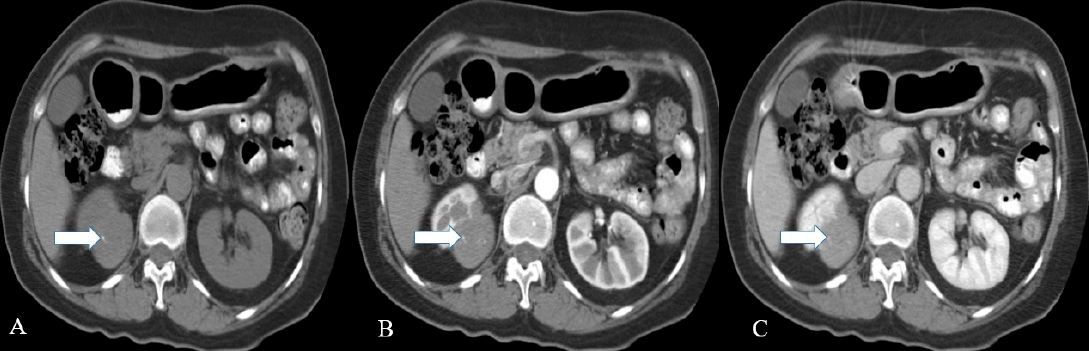
Figure 5. A 57-year-old female with renal NEN. CT scan of the abdomen before ( A ) and after oral and IV contrast administration in arterial ( B ) and porto-venous ( C ) phases reveal a right renal upper polar well-defined mass (arrow) with flecks of calcifications, measuring 5 × 4 cm encroaching on the right perinephric space without appreciable involvement of the right renal hilum. Pathology re-